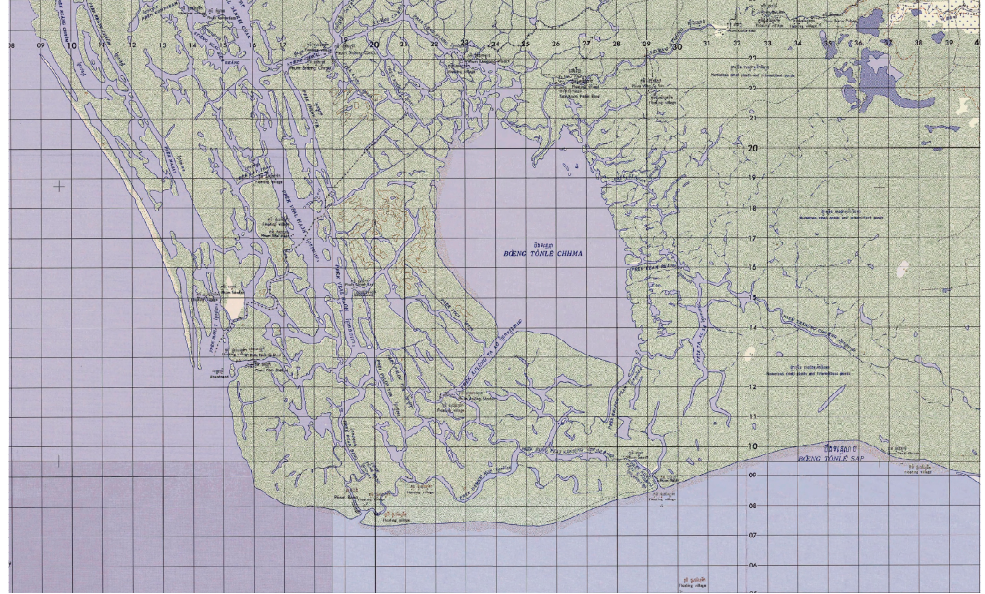
Figure 2. Topographic condition of Boeng Chhmar and its villages in the 1960s. (excerpt from Cambodia National Topographic map of 1:50,000 of US Military 1968-1969. Available online: http://gigapan.com/gigapans/130187, accessed on 6 November